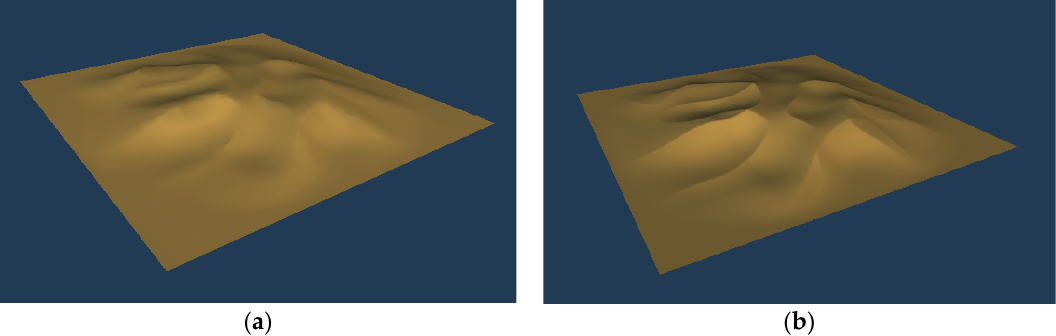
Figure 8. ( a ) Sand pile model from the improved version of the game. ( b ) Tree model from the